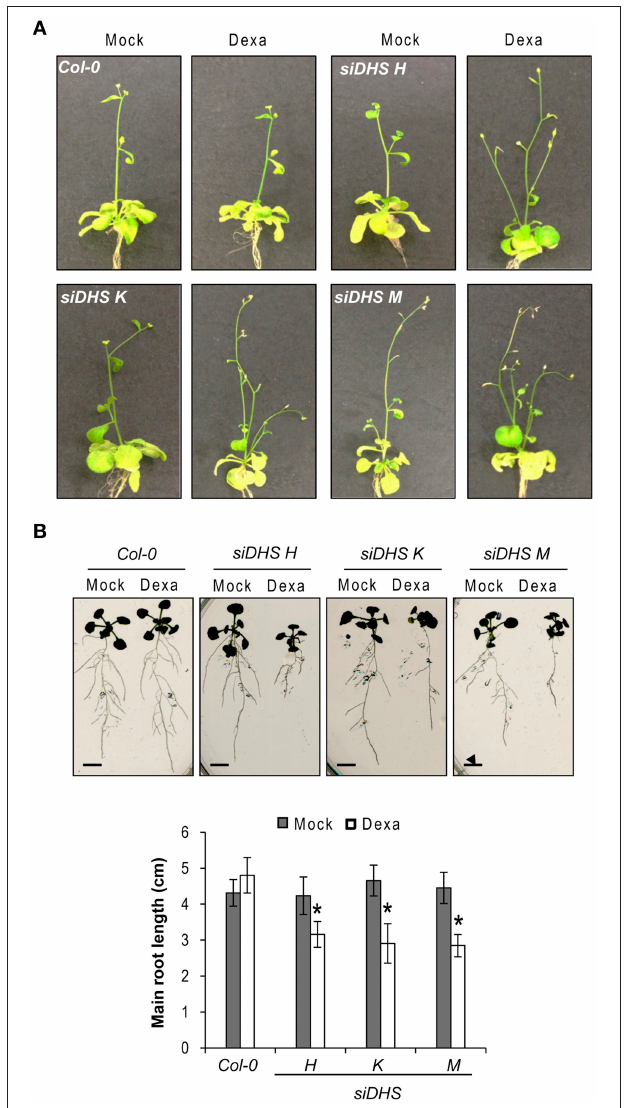
FIGURE 3 | Developmental alterations in shoot and root growth upon DHS silencing. (A) Representative images of 25-day-old wild type and siDHS transgenic plants grown in vitro under long-day conditions with (dexa) or without (mock) dexamethasone showing a bushy phenotype when DHS is silenced. (B) Root growth was analyzed on 14-day-old wild type and siDHS plants treated or not with dexamethasone. A representative image shows root growth defects upon dexamethasone treatment for siDHS plants. The length of the main root of at least 5 individual plants of each transgenic line and treatment was quantified with ImageJ and the results are shown below. Asterisks indicate significant differences ( p < 0.05 ) with respect to wild type plants and with respect to the same mock-treated genotype. Scale bars represent